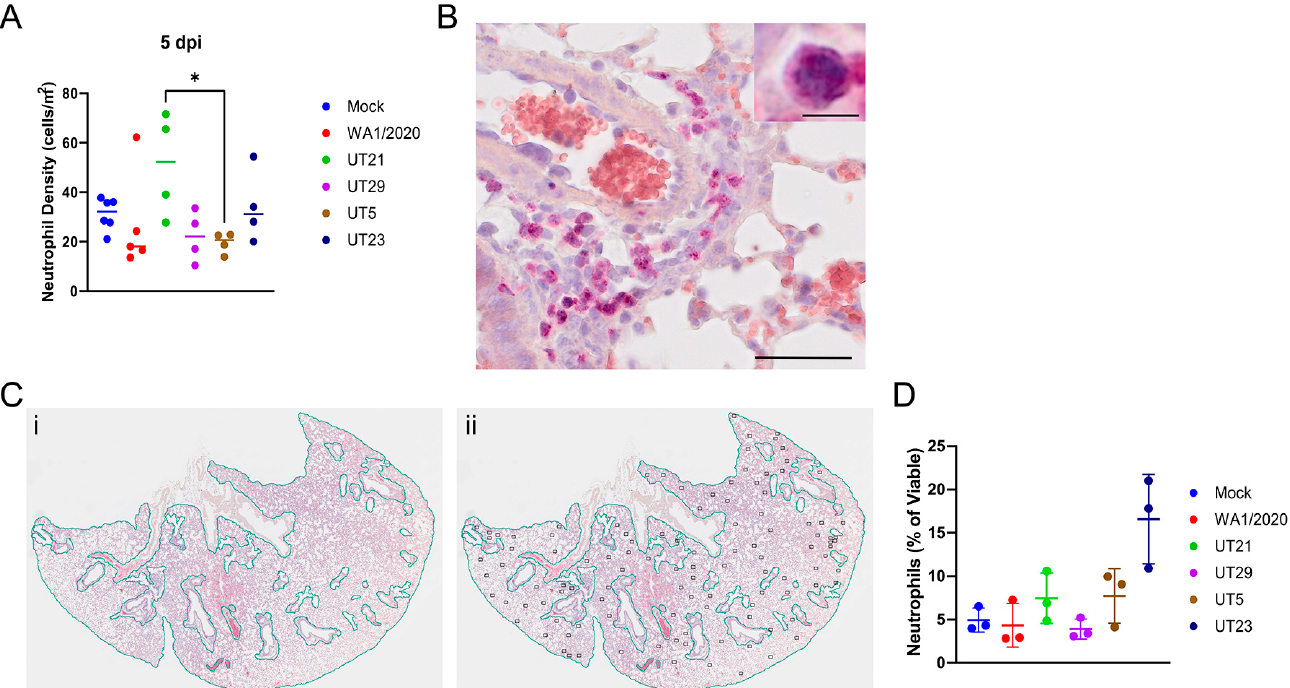
Figure 7. Quantification of neutrophil distribution and neutrophil density at 5 days pi within the lungs of SARS-CoV-2 infected mice. Neutrophils were stained pink with naphthol AS-D chloroacetate esterase (NACE) within lung tissues and counted. ( A ) Neutrophil density (cells/mm 2 ) of each of the five SARS-CoV-2 virus isolates in n = 5 mice. * p < 0.05, one-way ANOVA with post-hoc Tukey HSD test. The adjusted p -value comparing UT5 and UT21 at 5 dpi is 0.0467. ( B ) Representative image to show NACE staining. ( C ) Method of calculating neutrophil density within lung tissue. (Panel (i)), the entire lung tissue was first outlined to obtain the area of the shape. Bronchioles, respiratory ducts, lymphatic vessels, and blood vessels were next outlined, and their combined square area was subtracted to estimate the total area of the tissue. (Panel (ii)), neutrophils were highlighted throughout the tissue and this number was divided by the total estimated area of the whole lung tissue. Only one lobe is shown for illustration of method. ( D ) The percentage of viable neutrophils at 5 dpi in the lungs of mice infected with five SARS-CoV-2 virus isolates in n = 3 mice. Graphs ( A , D ) show each virus with a distinct color and each point represents one mouse with the mean for each group.